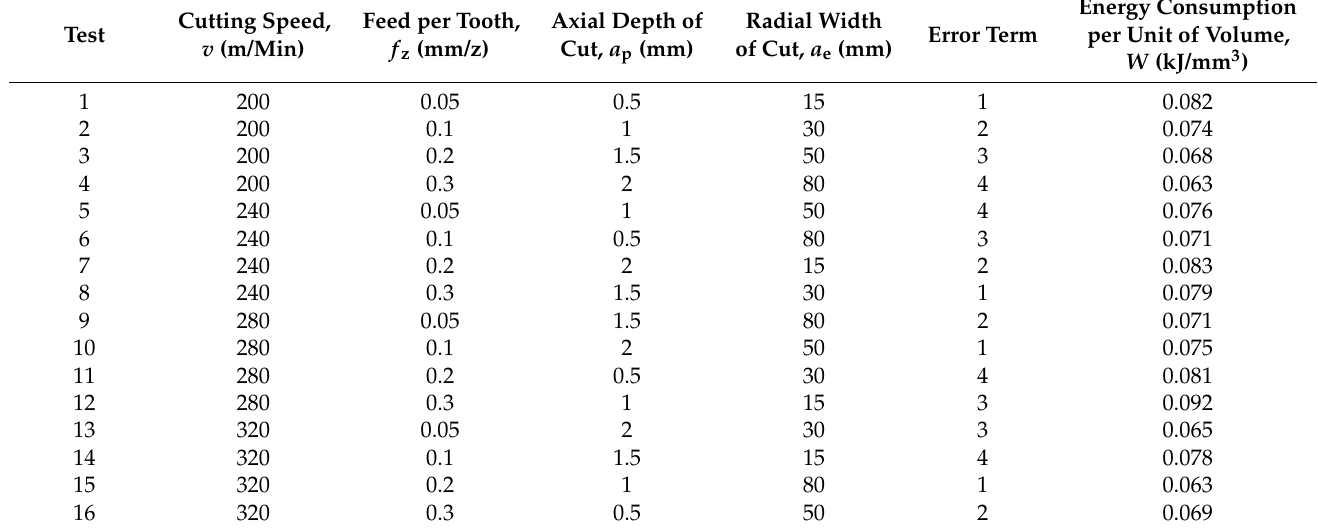
Table 2. Orthogonal array of cutting parameters and corresponding experimental results of energy consumption per unit of volume.